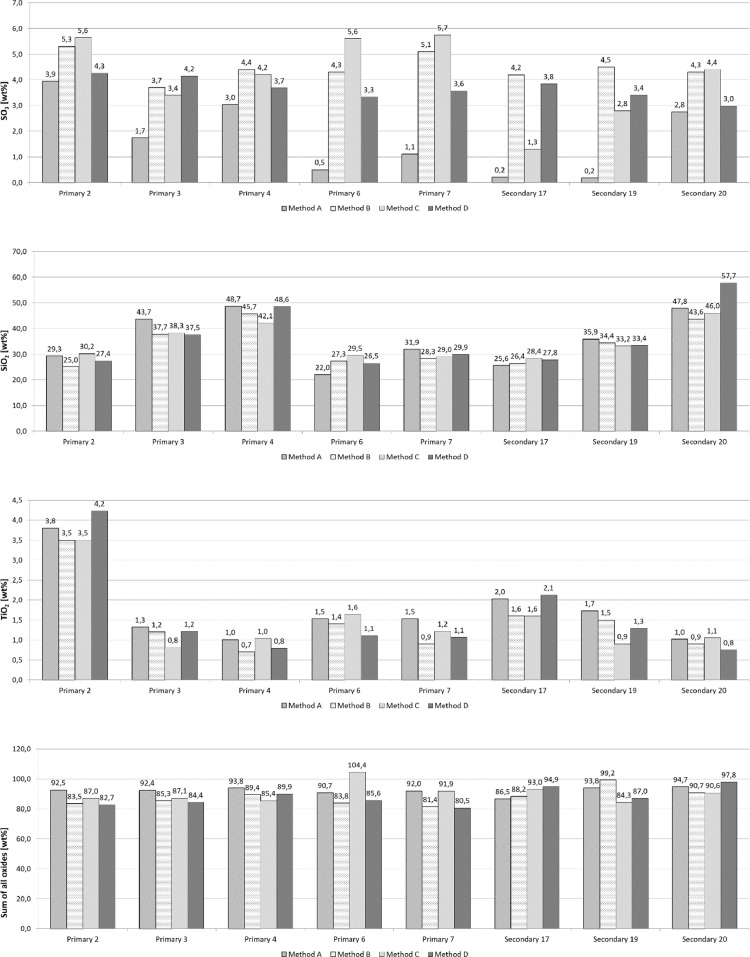
Results for SO3, SiO2, TiO2 and the sum of all measured oxides for all analytical methods for randomly selected samples.